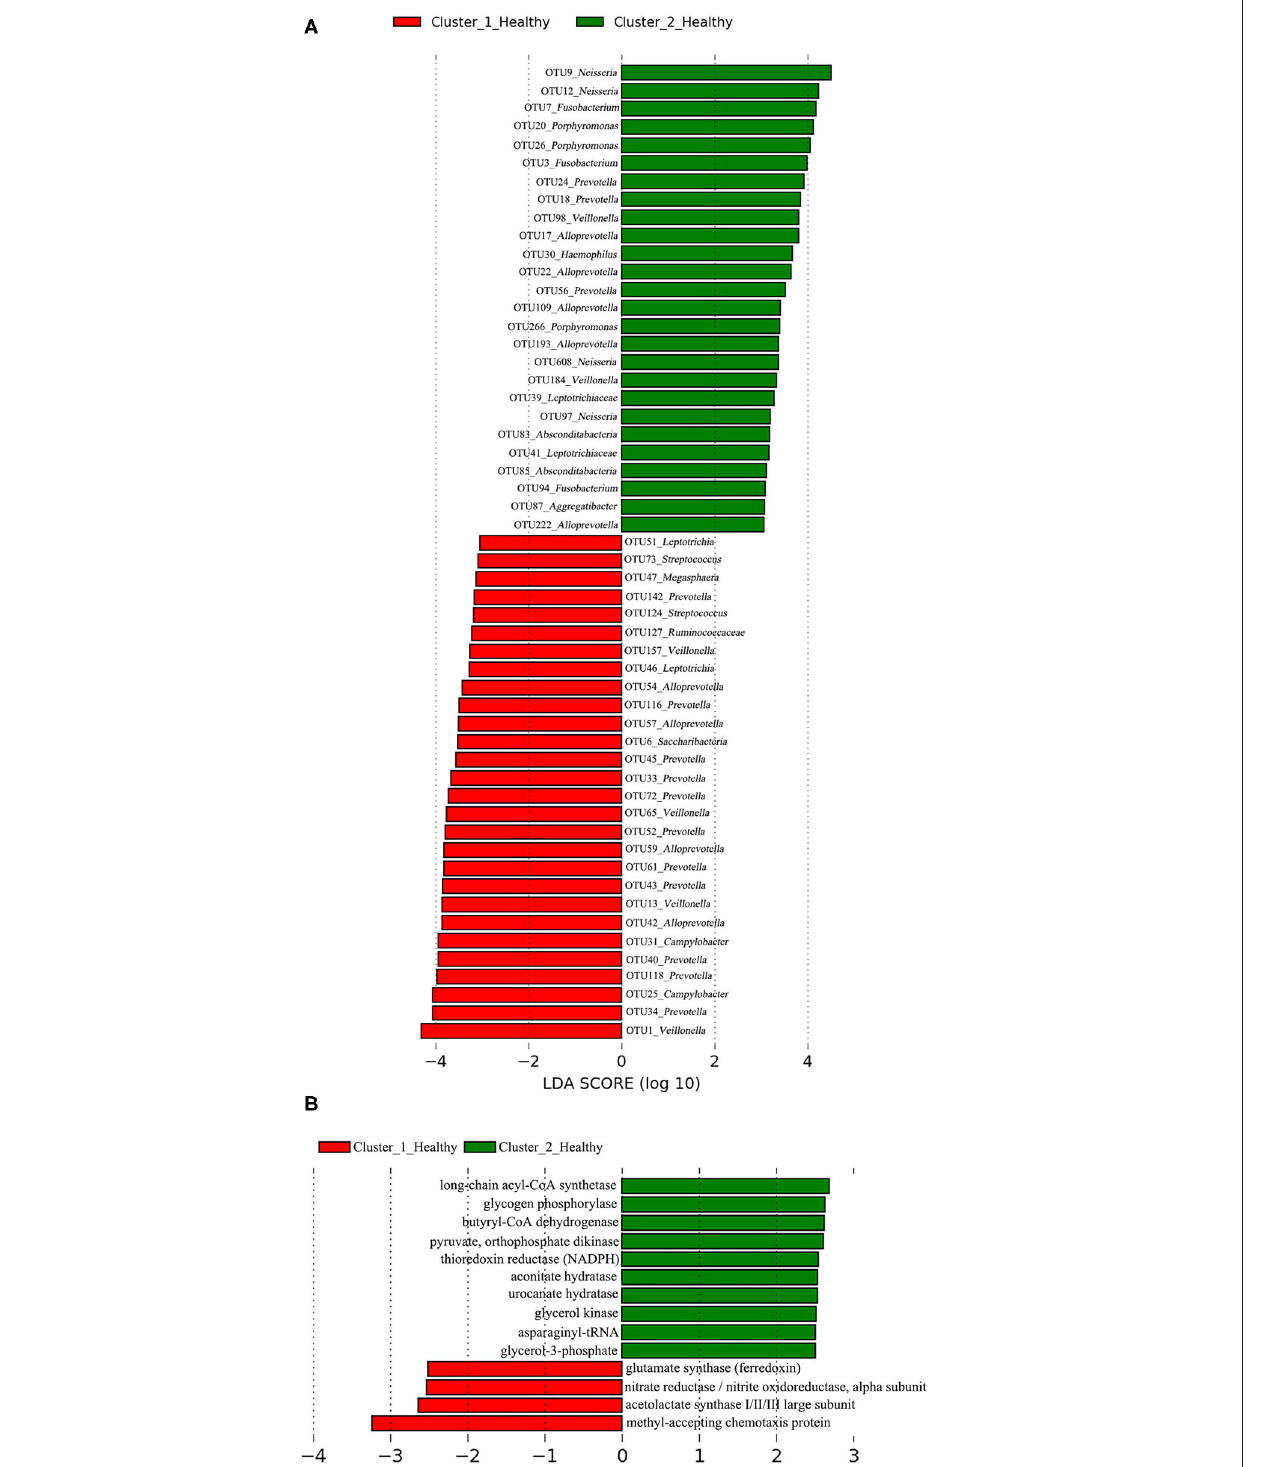
Frontiers in Medicine |